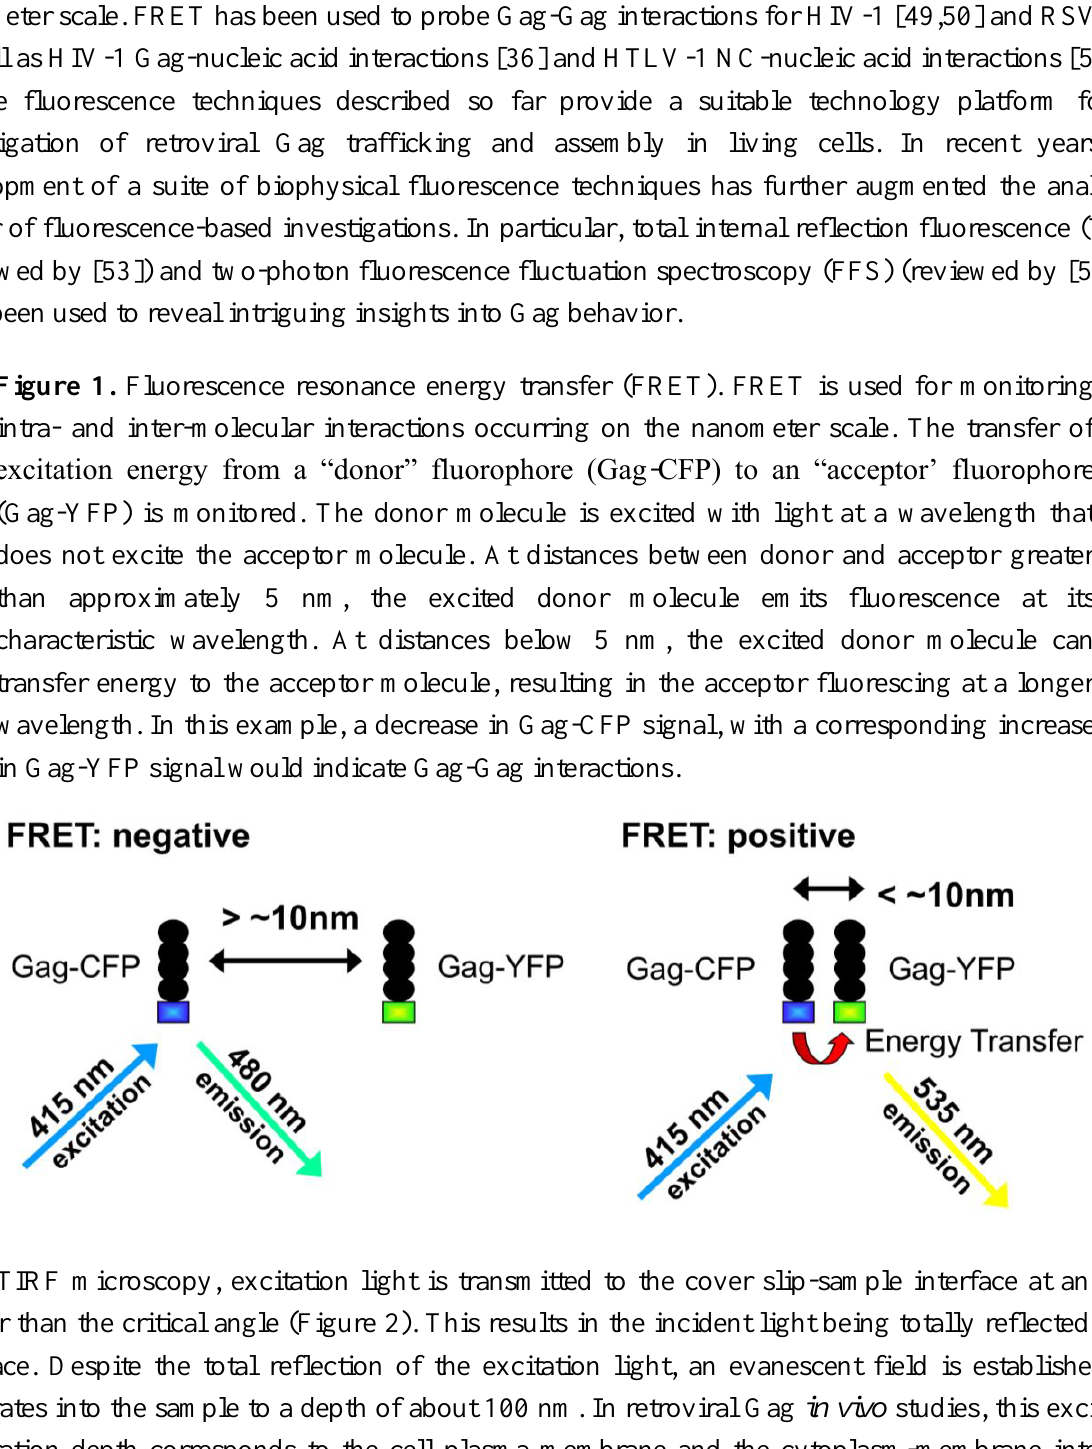
Figure 1. Fluorescence resonance energy transfer (FRET). FRET is used for